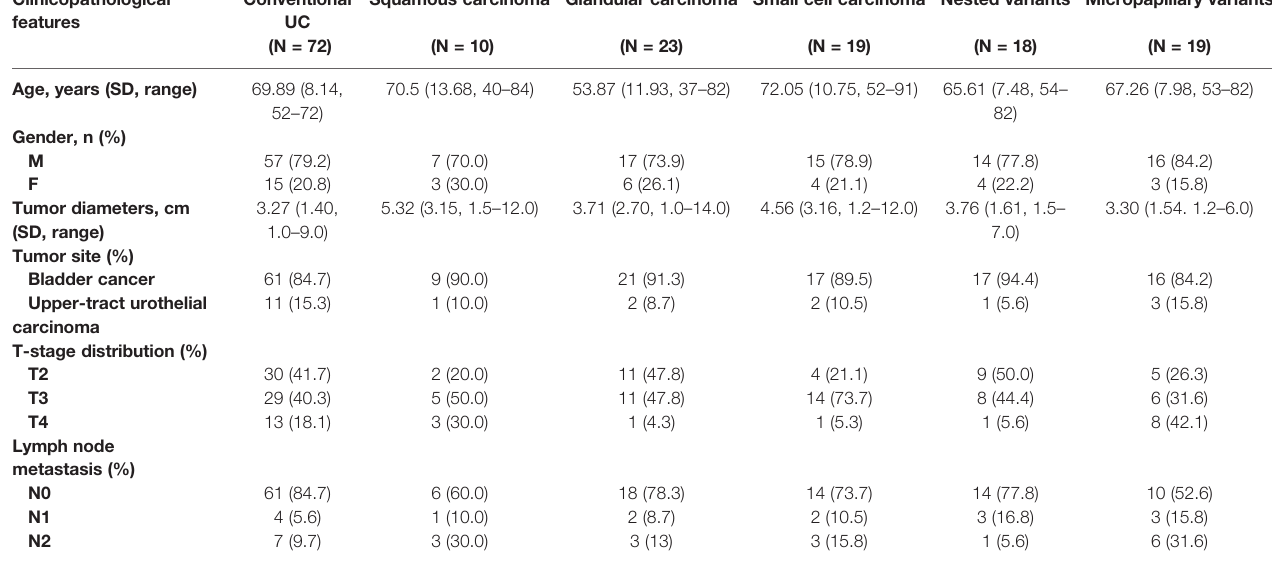
TABLE 1 | Clinicopathologic characteristics of patients